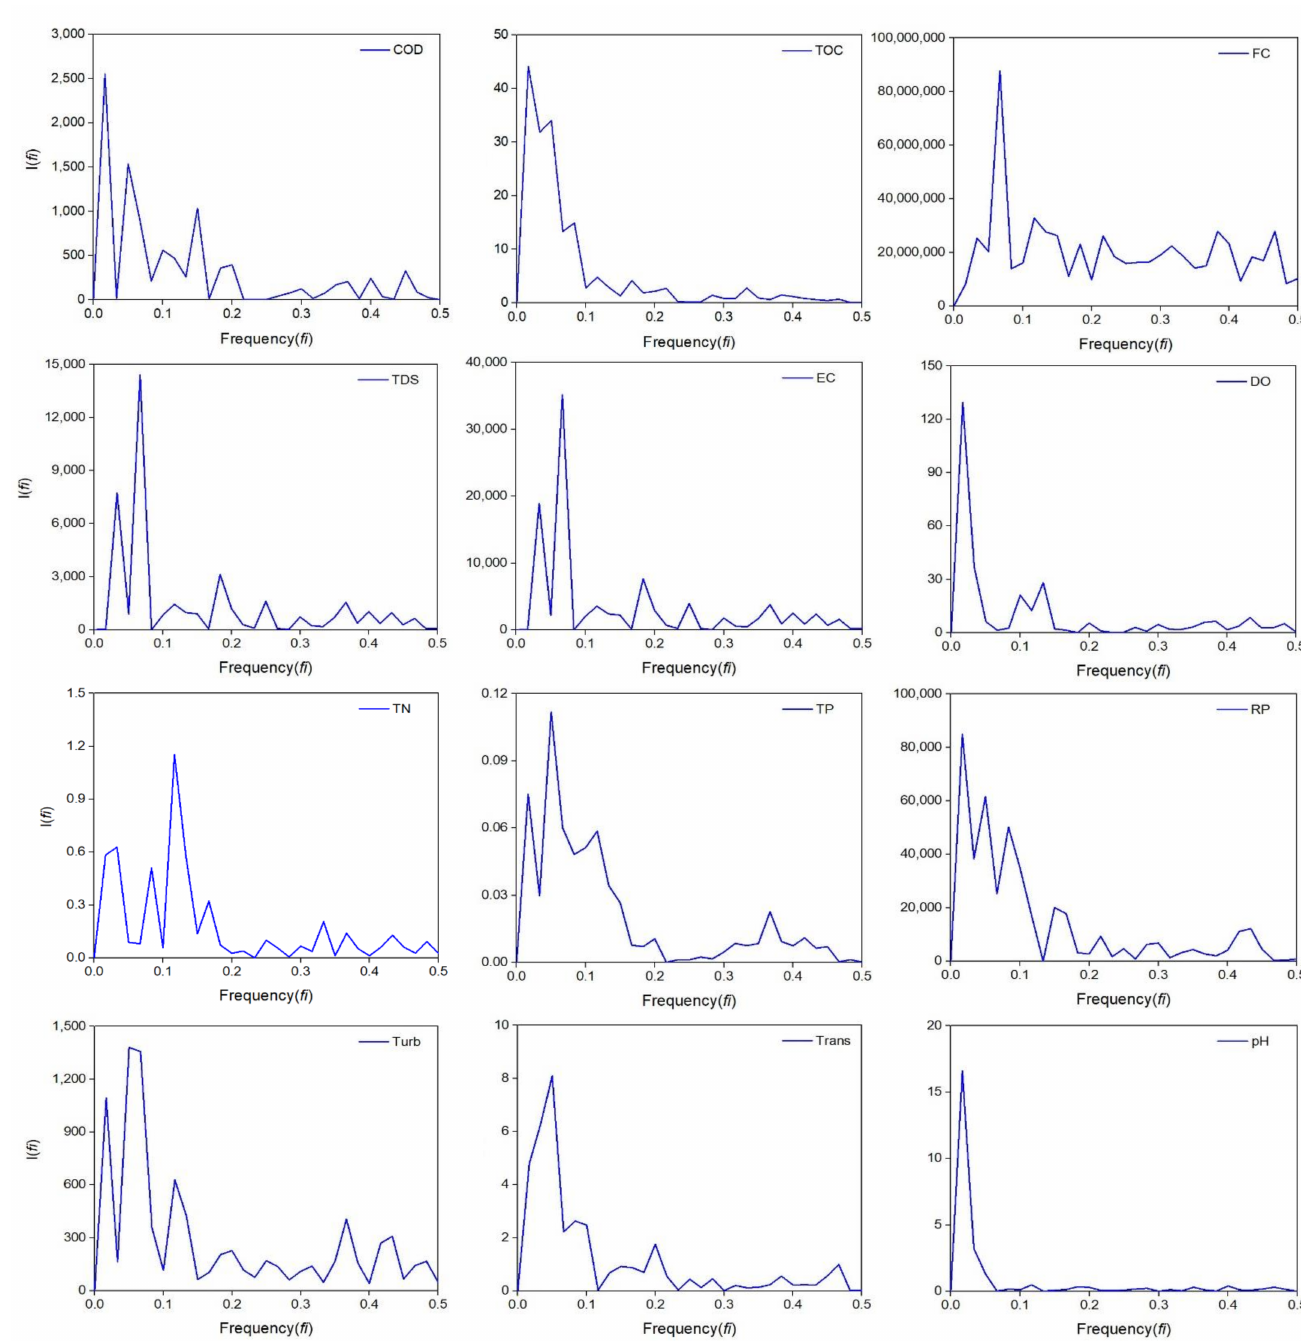
Figure 6. Periodograms of water quality parameters in ALM